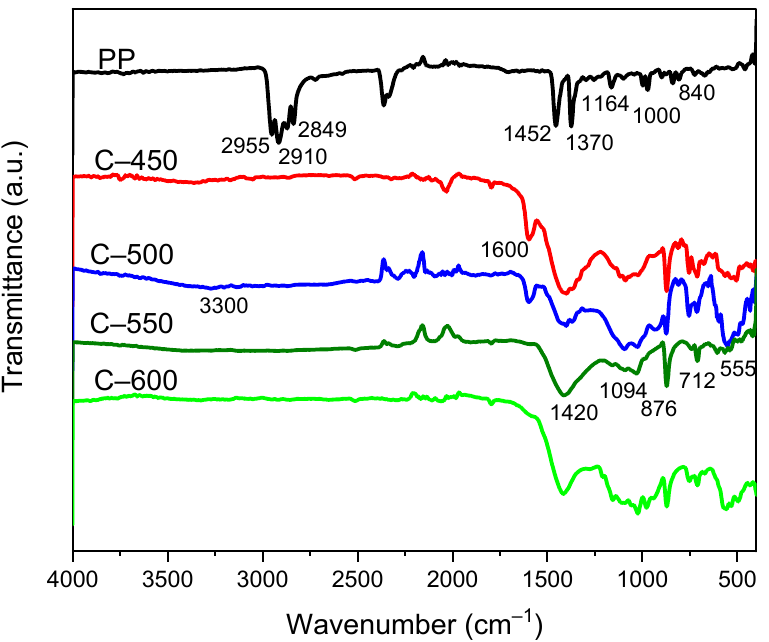
Figure 7. FTIR–ATR spectra of raw PP-IG and chars collected from pyrolysis with different temper- atures.